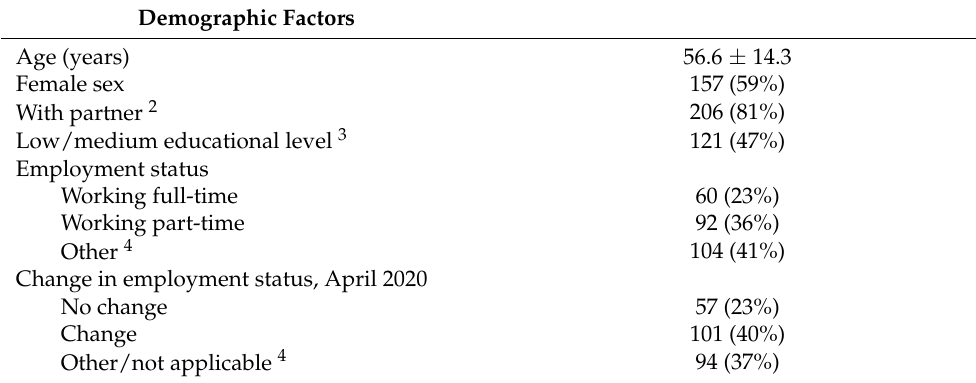
Table 2. Sociodemographic characteristics of the study sample ( n = 259) 1